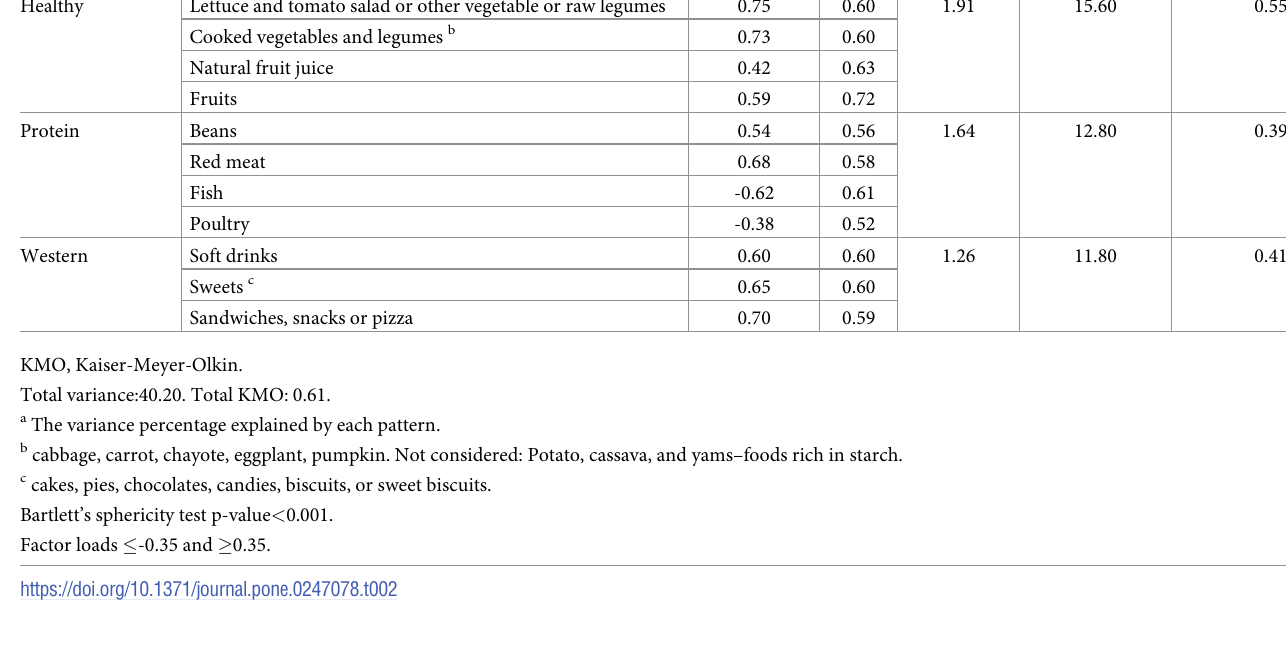
Table 2. Brazilian dietary patterns components identified by Factor Analysis (FA). Dietary